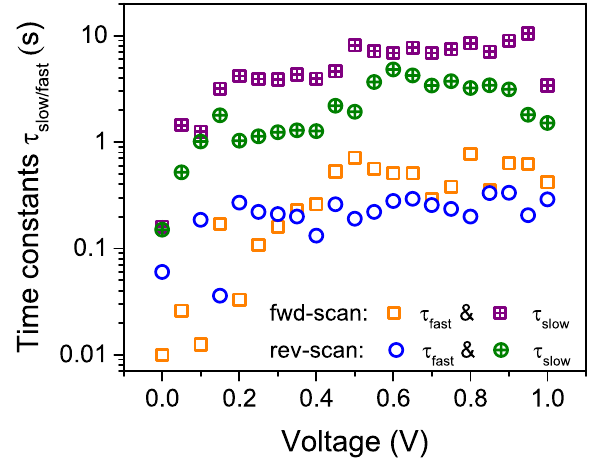
Figure 3. Fast and slow time constants ( τ fast and τ slow ) extracted by fitting the transient current response in each voltage segment to the bi-exponential fit function given in Equation (1) both for the forward (fwd) scan and for the reverse (rev) scan